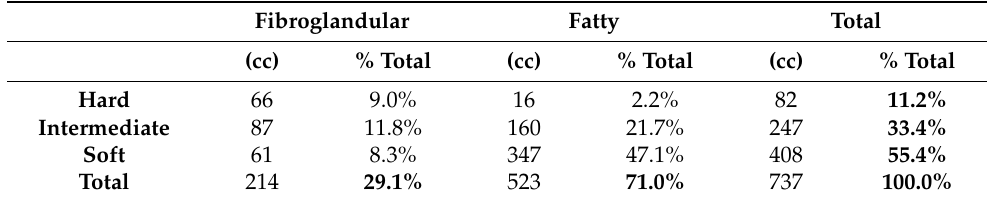
Table 3. The average volumetric distributions of the three stiffness components for fibroglandular and fatty tissues throughout the average whole breast (i.e., mean total breast volume = 737 cc; N = 239 breasts).